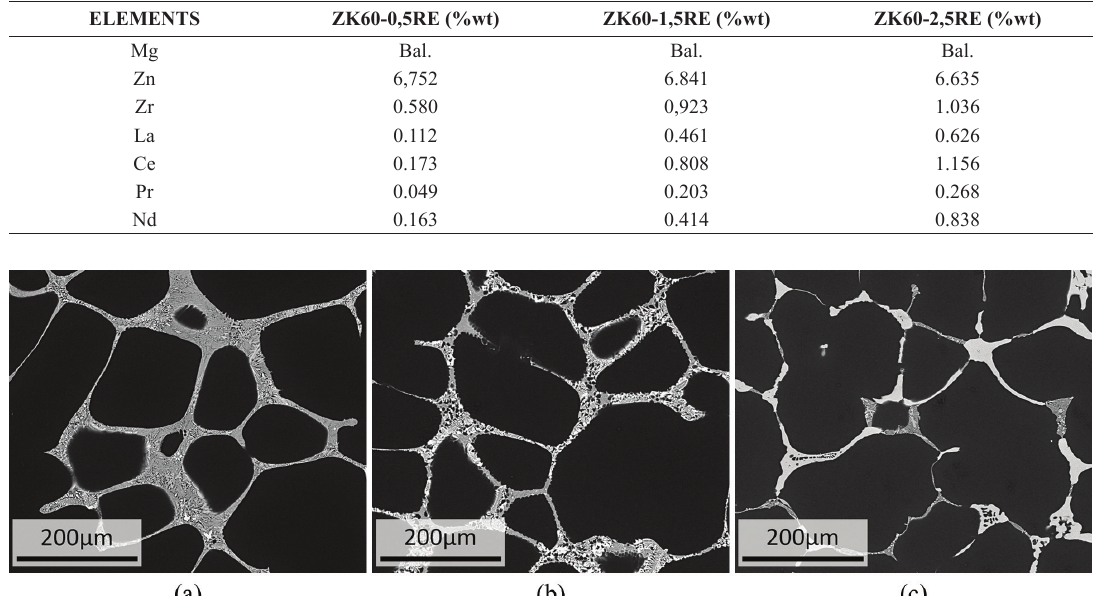
Table 1. Chemical composition of investigated alloys.